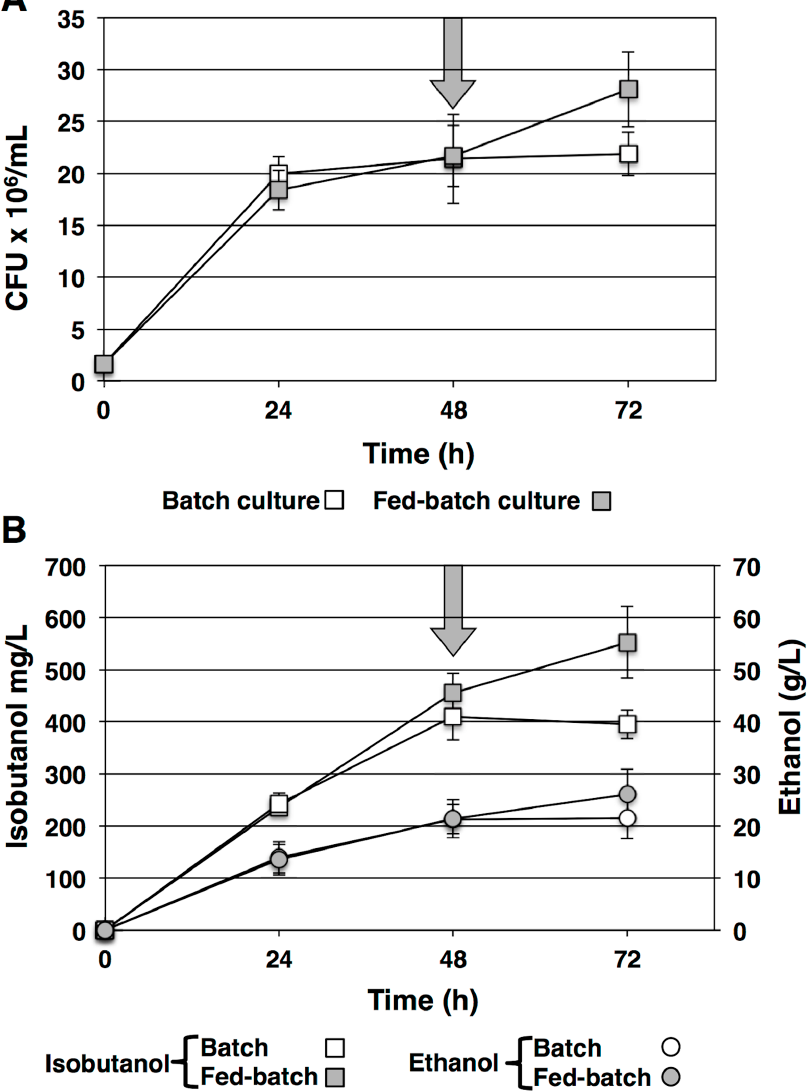
Figure 2. SSF in batch (open symbols) and fed-batch (filled symbols) fermentations of triticale starch. ( A ) Viable yeast cell counts at each time point determined by CFU. Data shown are mean values from triplicate platings. Error bars indicate standard deviation. ( B ) Isobutanol concentration in mg/L in fermentation reactions (square symbols), ethanol concentration in g/L in the fermenta- tion reactions (circles), batch fermentation values are shown in the open symbols and fed-batch in filled symbols. The vertical arrow indicates the time of the starch feed addition. Values displayed are the means of triplicate cultures. Error bars indicate standard deviations.